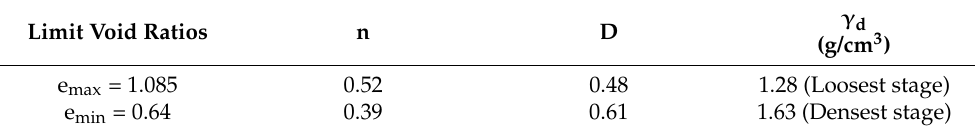
Table 7. Limit index voids for the tested sand estimated from Yilmaz